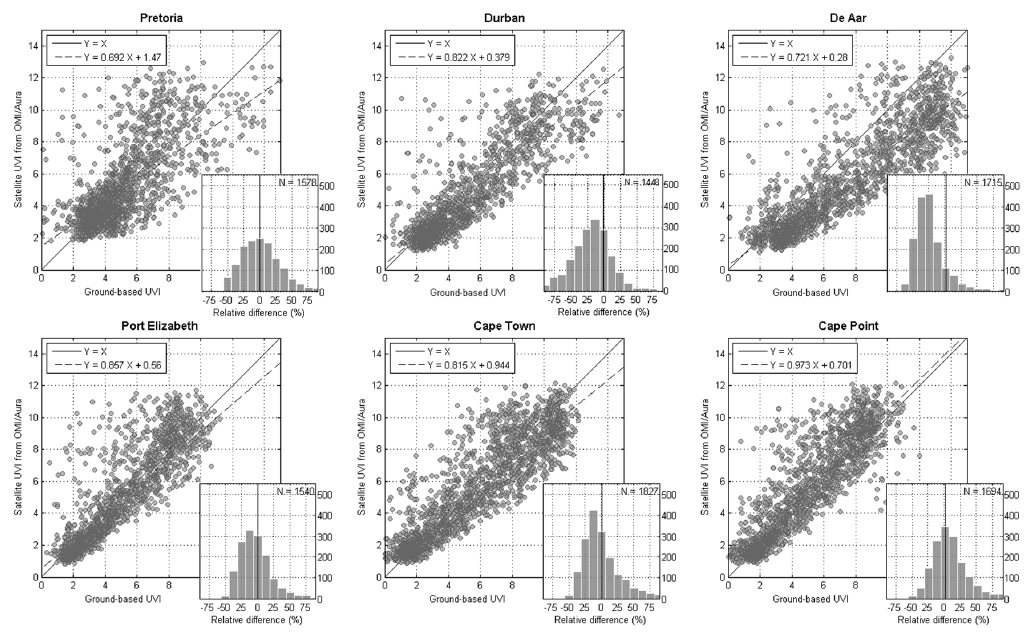
Figure 8. Correlation between the ground-based UV index and satellite-derived UV index data for 2005 to 2015 at the six South African sites at satellite overpass time. The six inserted histograms show the relative difference between the two datasets by the number of observations for each respective site (the comparison was performed at the satellite overpass time and only clear sky days are selected with LER).